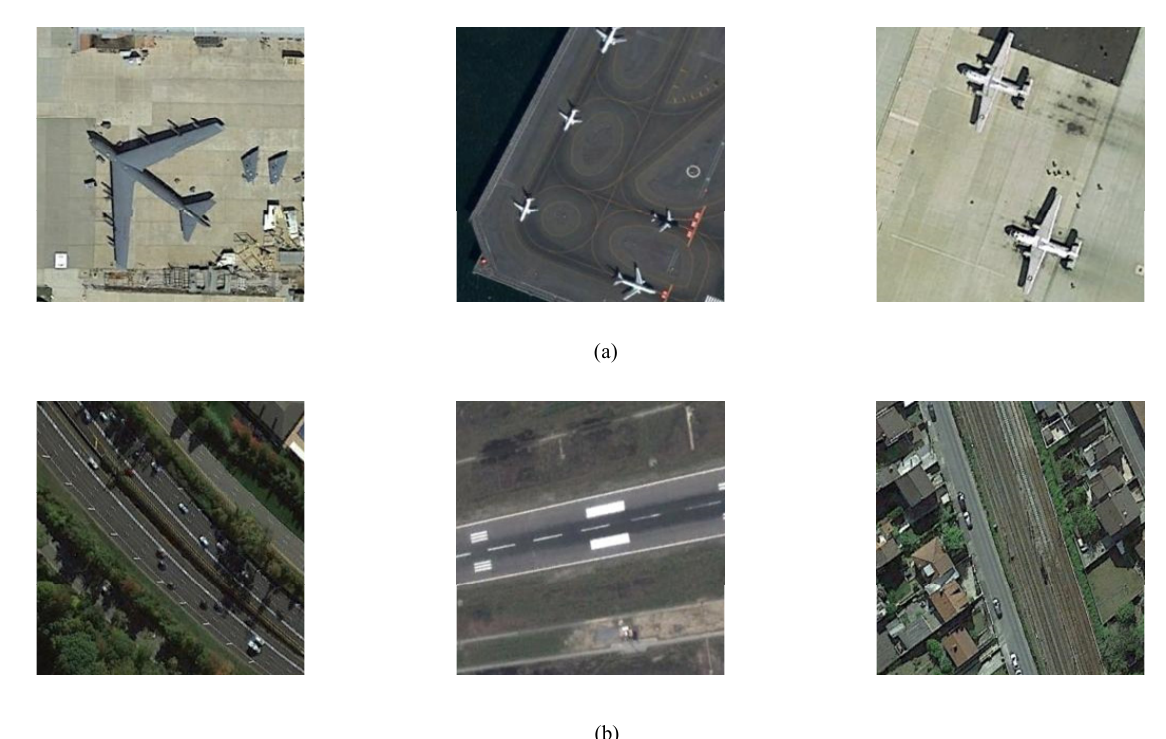
Figure 2. Remote-sensing scene images. ( a ) High intra-class differences: airplane. ( b ) High inter-class similarities: highway, runway, railway.